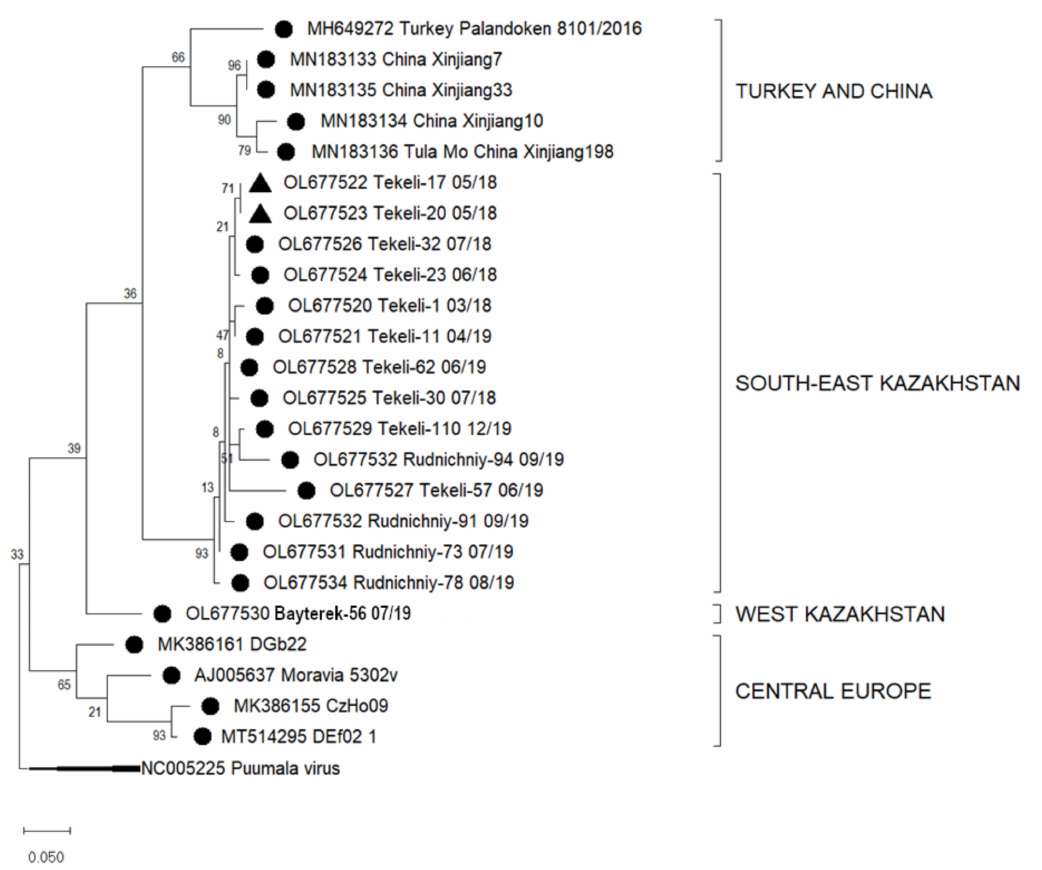
Figure 3. Phylogenetic analysis by Maximum Likelihood method of the L segments (184 nucleotides (nt), positions of sequences 5187–5371 nt in regard to the reference sequence NC005226) of Tula virus in Kazakhstan. The tree with the highest log likelihood ( − 1345.67) is shown. The percentage of trees in which the associated taxa clustered together is shown next to the branches. This analysis